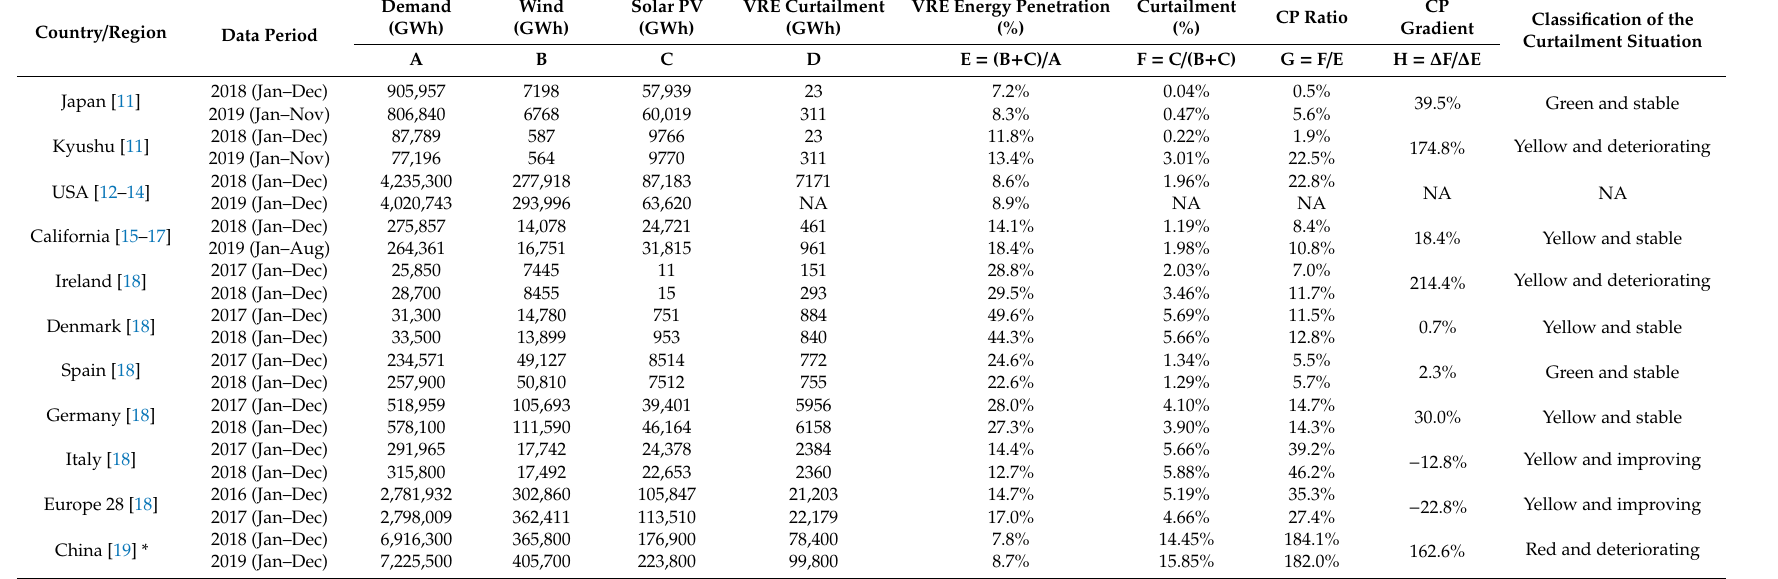
Table 1. Statistical data for several countries and regions and the resulting curtailment